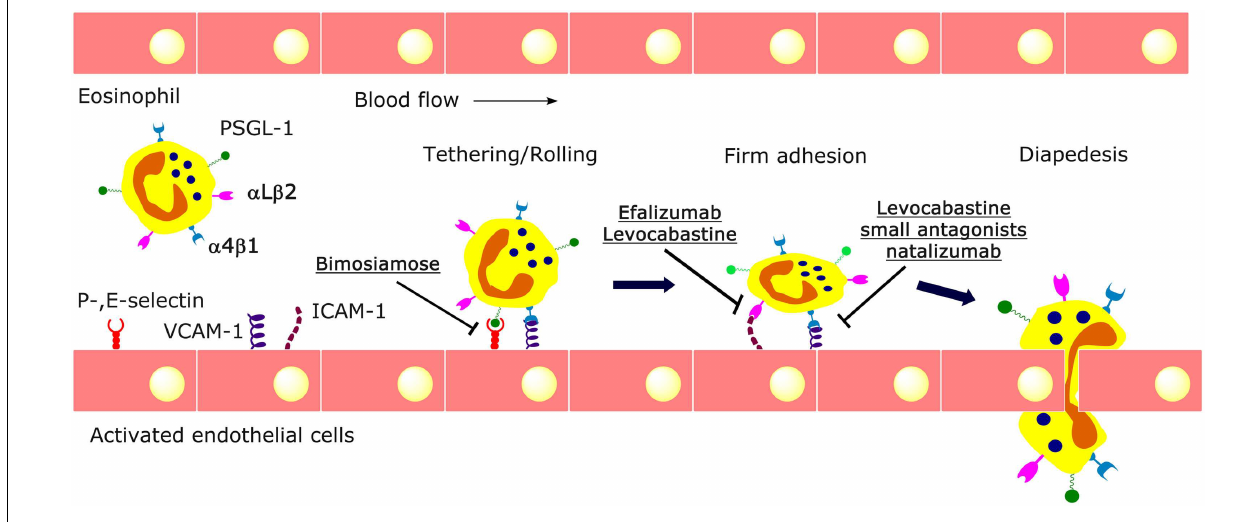
bimosiamose, a selectin antagonist, blocks the recruitment of eosinophils mediated by E-selectin.The antihistamine levocabastine, several small antagonists, and the monoclonal antibody natalizumab can interfere with the interaction between α 4 β 1 integrin andVCAM-1, while efalizumab and levocabastine can affect α L β 2 /ICAM-mediated